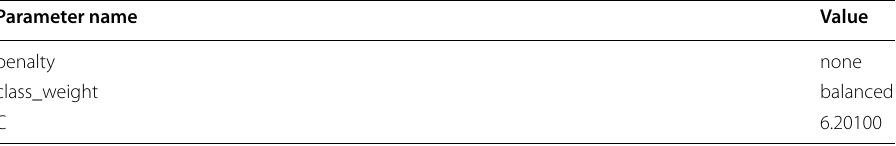
Table 90 Modes of LR tuned hyperparameter values for experiments with the data exfiltration dataset